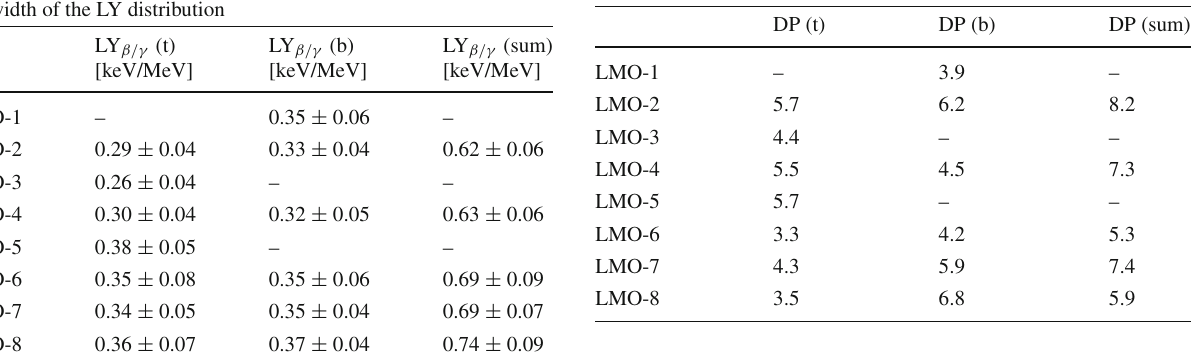
Table 2 Discrimination Power (DP) achieved with the top LD (t), the bottom LD (b) and the sum of the two light detectors with bare crystals. LMO-1 to LMO-4 are in the baseline configuration (bottom LD spaced 0.5mm and top LD spaced 4mm). LMO-5 to LMO-8 are in the